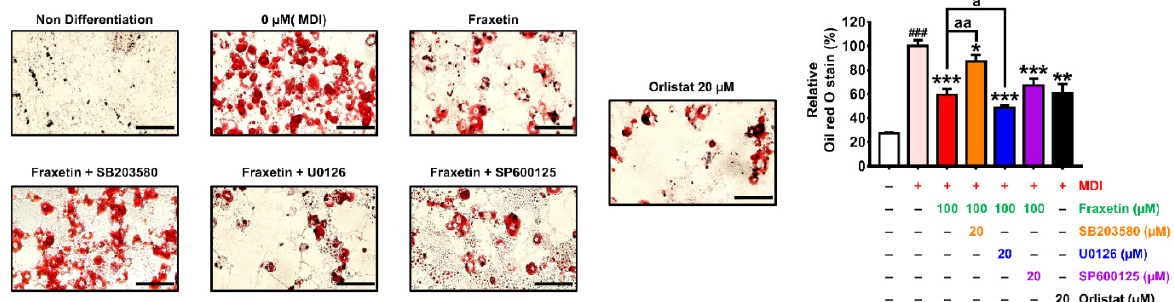
Figure 7. Effect of the combination of fraxetin and MAPK inhibitors on lipid accumulation. Fraxetin was cotreated with MAPK signaling inhibitors including SB203580, U0126, and SP600125 in the presence of an MDI induction medium. Then, the formation of lipid droplets was evaluated with oil red O solution. Relative staining rates were assessed by measuring the optical density at 490 nm. Scale bar: 50 µ m. The red and black color represent the treatment with fraxetin and orlistat in the presence of MDI medium, respectively. The orange, blue, and purple colors in bar graph indicate the treatment with SB203580, U0126, and SP600125 in the presence of fraxetin, respectively. Experiments were performed at least three times. The crosshatch represents significant differences between the nondifferentiated group and others (### p < 0.001). The asterisk symbol represents significant differences between the MDI-treated group and others (* p < 0.05, ** p < 0.01, *** p < 0.001). The symbol “a” (p < 0.05) and “aa” (p < 0.01) represent the significant effect of combination treatment between the fraxetin and MAPK-inhibitor-treated groups, as verified using one-way analysis of variance (ANOVA), followed by Dunnett’s post hoc